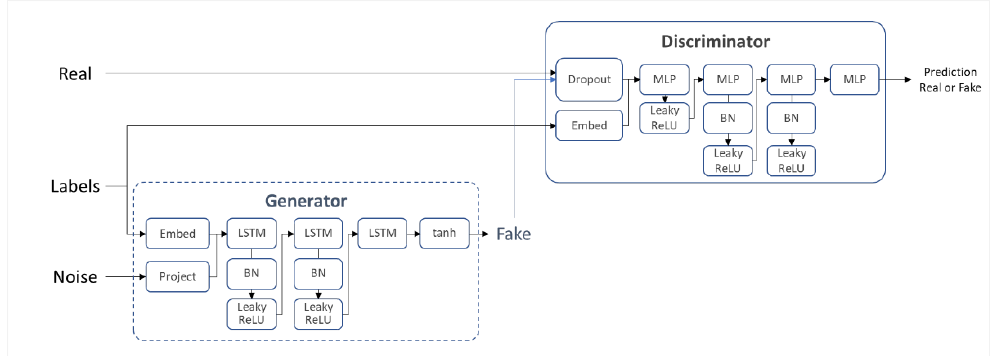
Figure 1. Structure of Conditional GAN for synthetic consumer credit data. Synthetic data generation begins by setting the order of accounts as the condition 𝒚 .